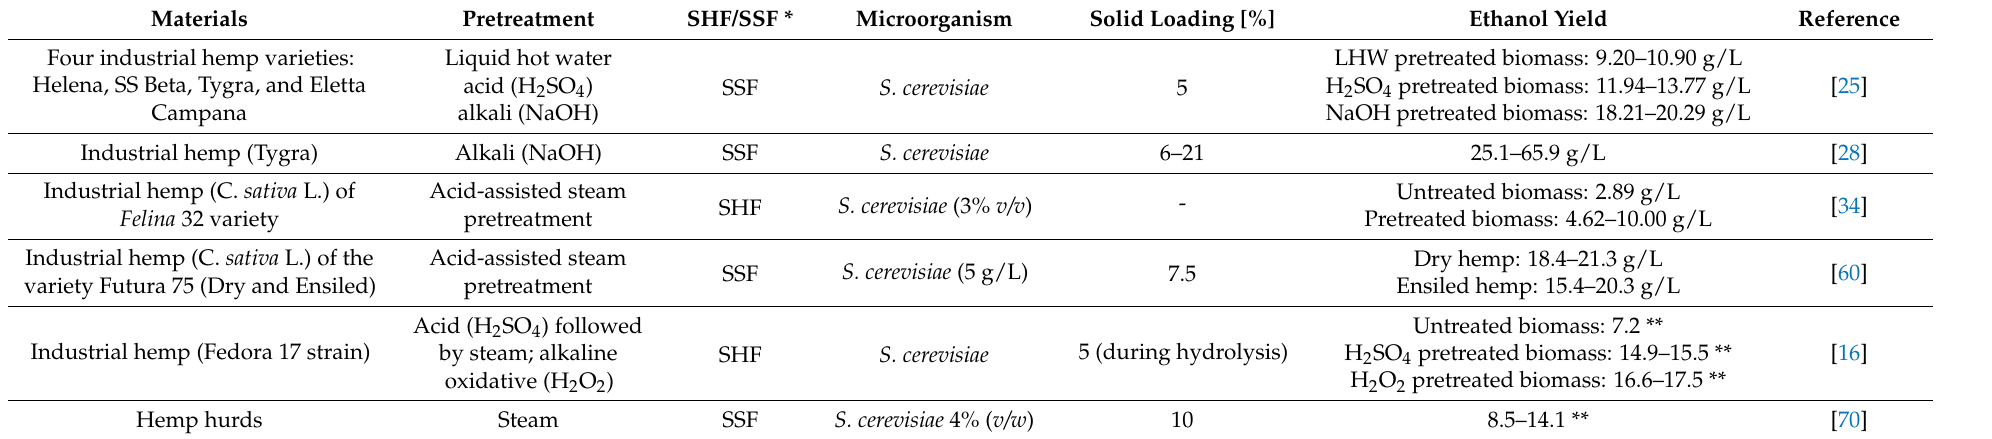
Table 4. Fermentation of hemp biomass for ethanol